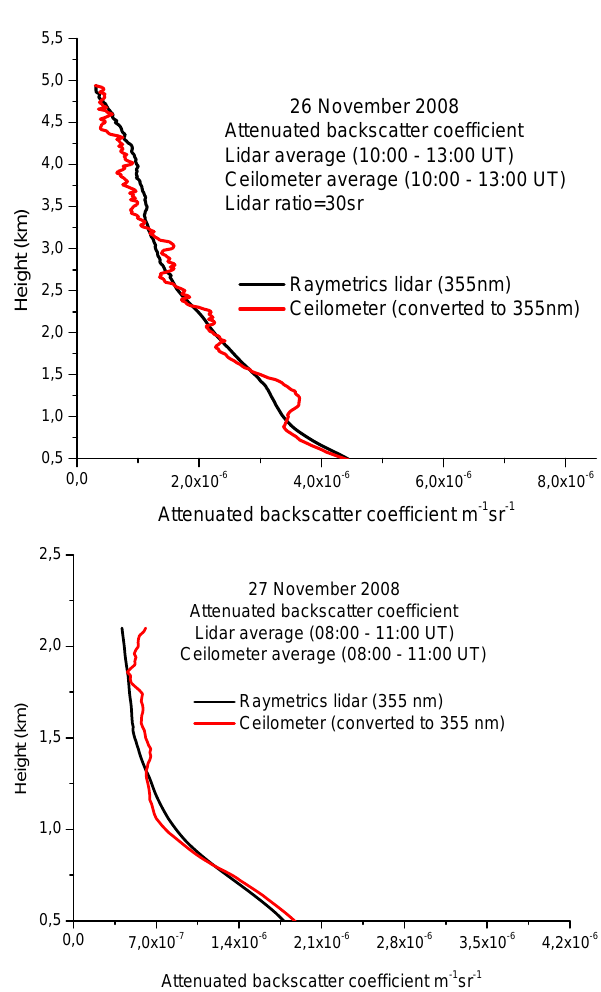
Fig. 4. Comparison of the attenuated backscatter coefficient profiles (in m − 1 sr − 1 ) obtained by the Vaisala ceilometer and the Raymet- rics lidar (a) on 26 November 2008 (10:00–13:00UT) and (b) on 27 November 2008